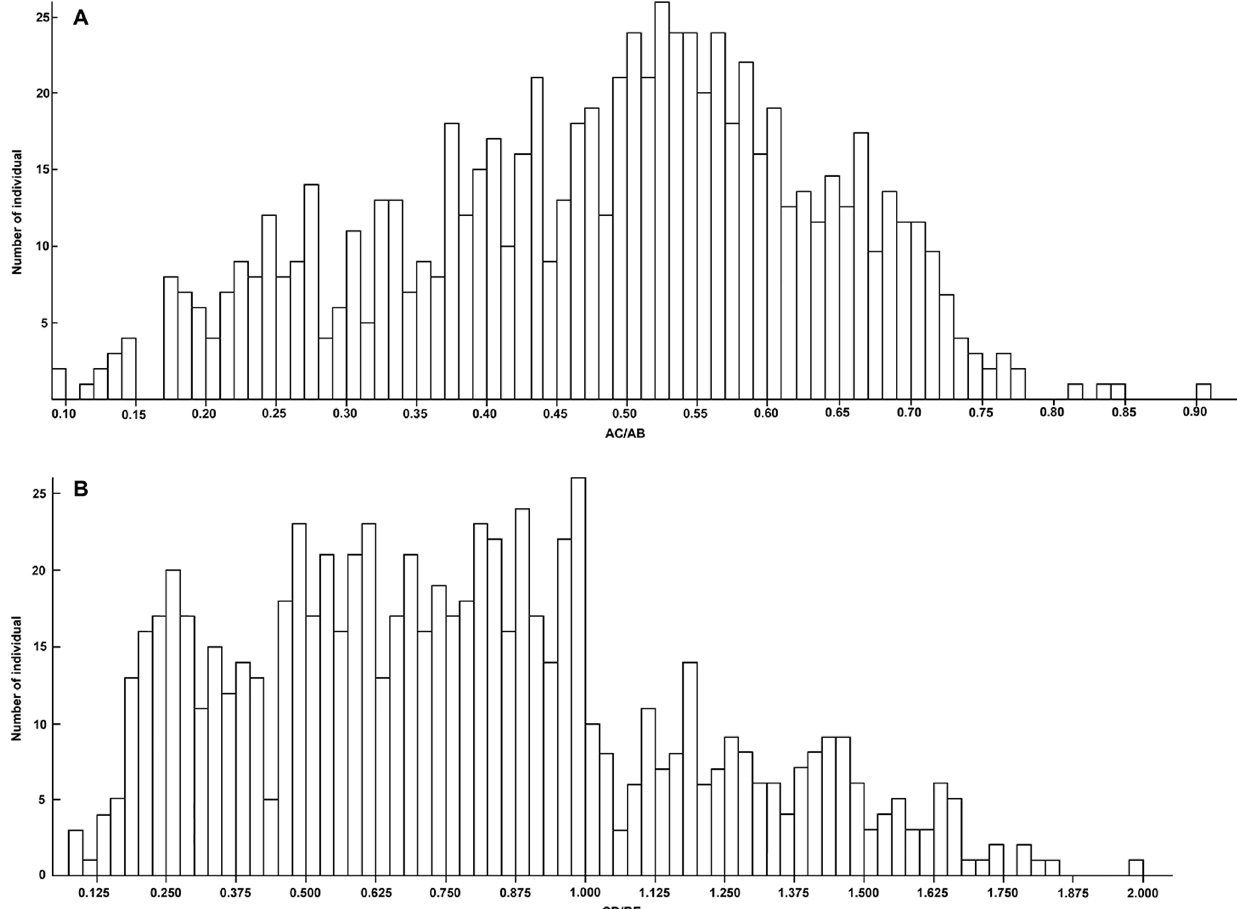
Figure 4. The numbers of individuals with different AC/AB (A) and CD/BE (B) values among the studied populations. doi:10.1371/journal.pone.0110760.g004 PLOS ONE |